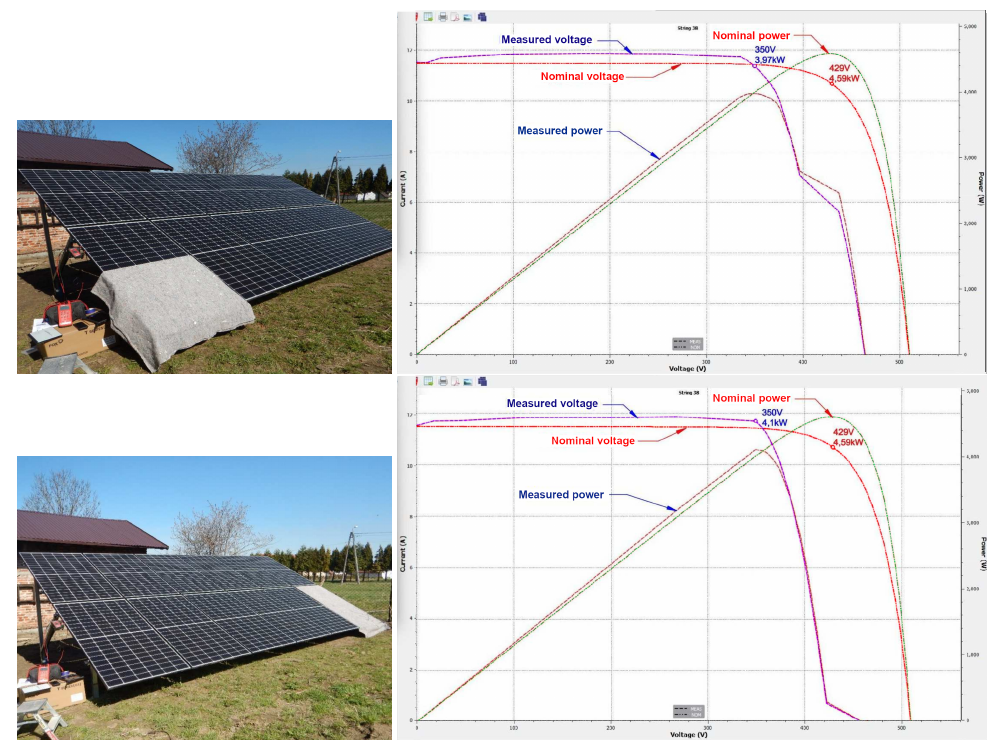
Figure 8. Impact of shading of half of the module on the characteristic of the string ( top row ) and shading of the whole module on the characteristic of the string ( bottom row ).